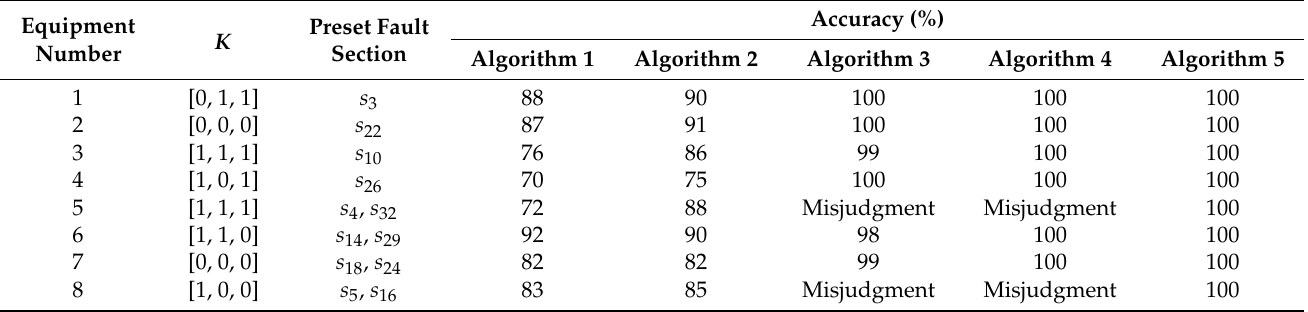
Table 5. Accuracy test